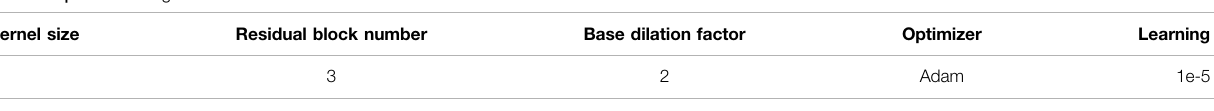
TABLE 3 | Model con fi guration.